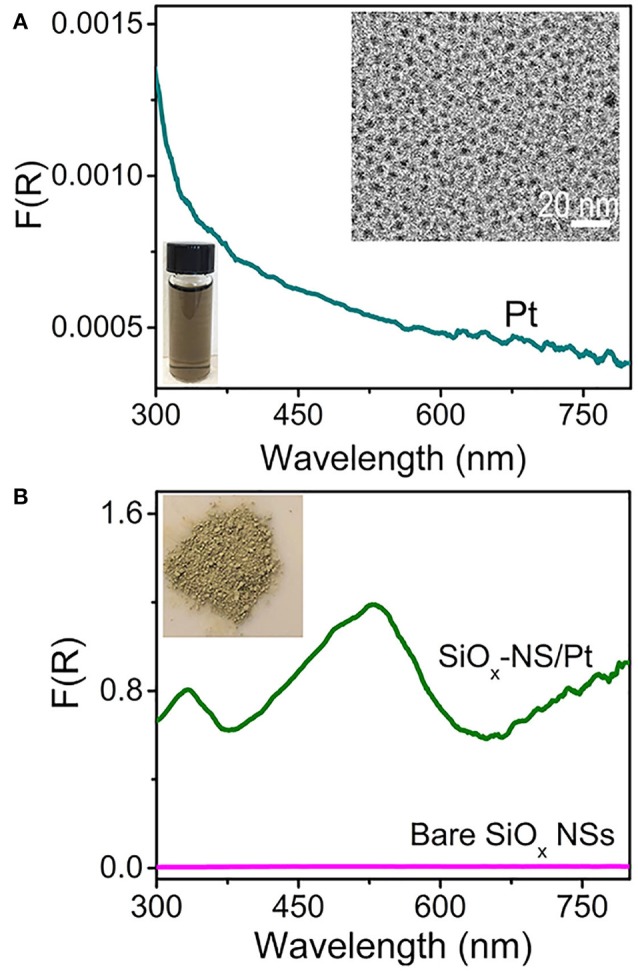
DRS spectra of (A) an aqueous dispersion of Pt nanocrystals and (B) a powder film of SiOx-NS/Pt composite particles. The DRS spectrum of a powder film of SiOx NSs is presented in (B) for reference. A representative TEM image of the Pt nanocrystals and a digital photograph of an aqueous dispersion of the Pt nanocrystals are presented as insets in (A). A digital photo of the powders of SiOx-NS/Pt composite particles is shown as inset in (B).